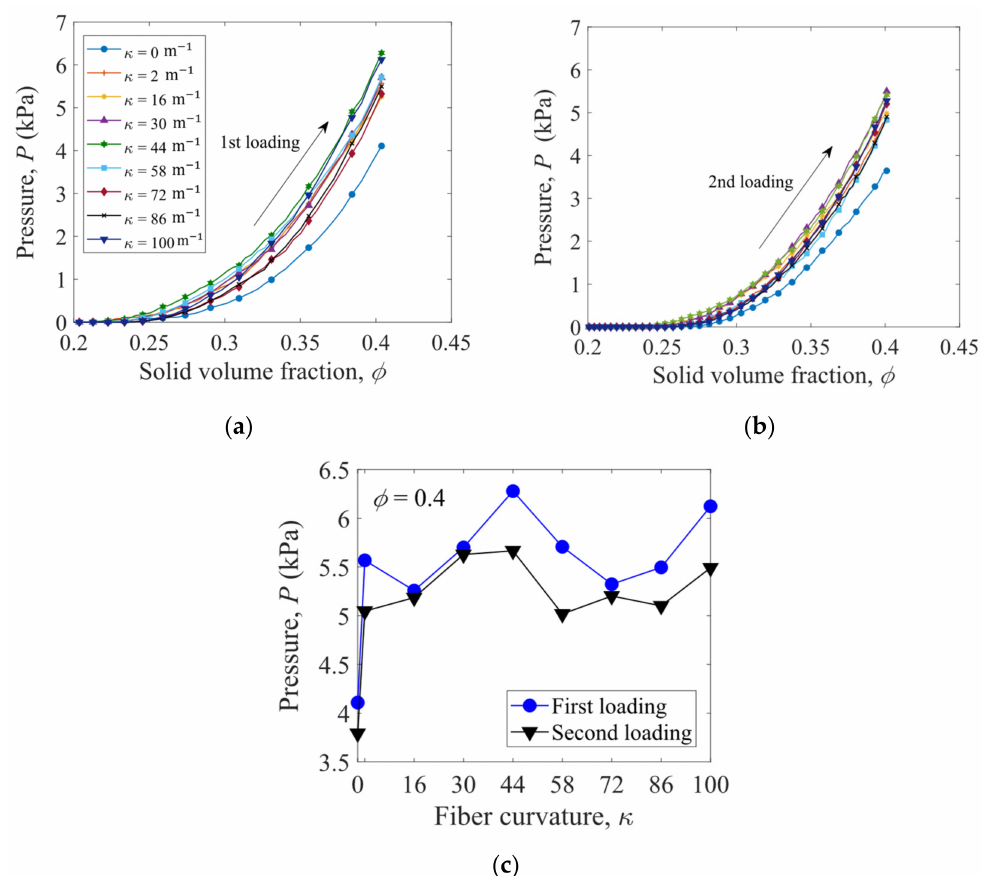
Figure 8. Pressure P versus solid volume fraction φ for ( a ) the first loading path and ( b ) the second loading path. The pressure P versus fiber curvature κ at φ = 0.4 is plotted in ( c ).